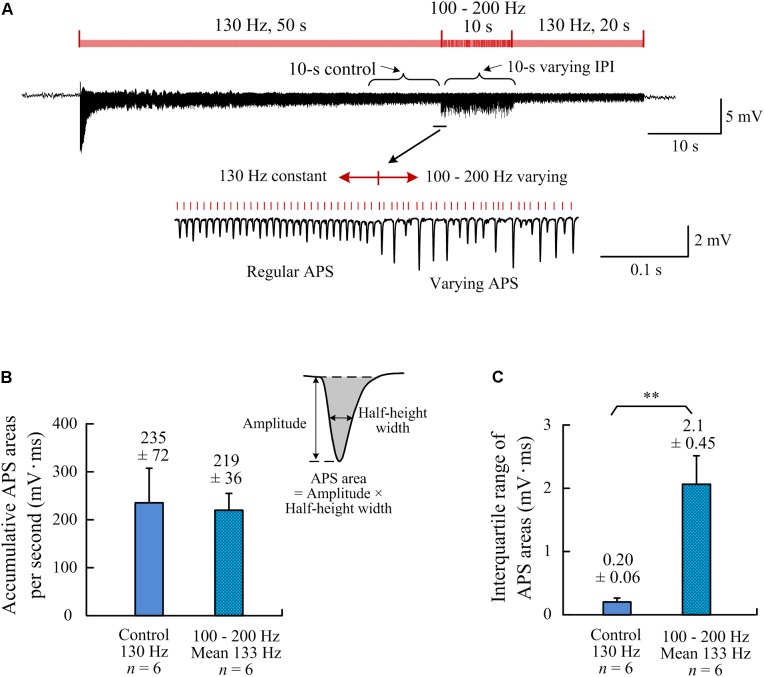
Comparisons of neuronal firing amounts quantified by APS areas during the two different A-HFS periods with constant IPI (control) and with random IPI (but with same amount of pulses). (A) a recording of 80-s A-HFS with constant IPI (130 Hz, during 0–50 s and 60–80 s) and random IPI (100–200 Hz, mean ∼130 Hz, during 50–60 s), together with expanded plots of APS waveforms. Red bars denote the stimulation pulses. (B) Comparisons of the accumulative APS areas between the control period of constant IPI and the period of random IPI (P = 0.64, n = 6, t-test). (C) Comparisons of the interquartile ranges of APS areas during the two different periods (∗∗P < 0.01, n = 6, t-test).